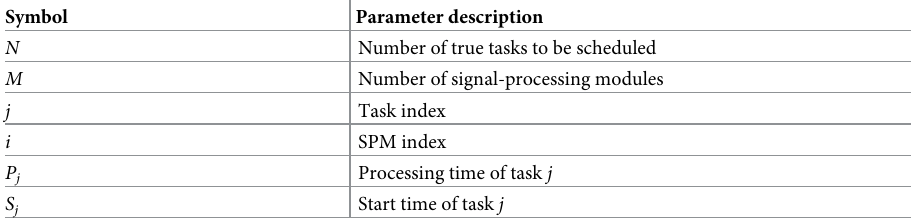
Table 1. Parameters of mixed integer linear programming